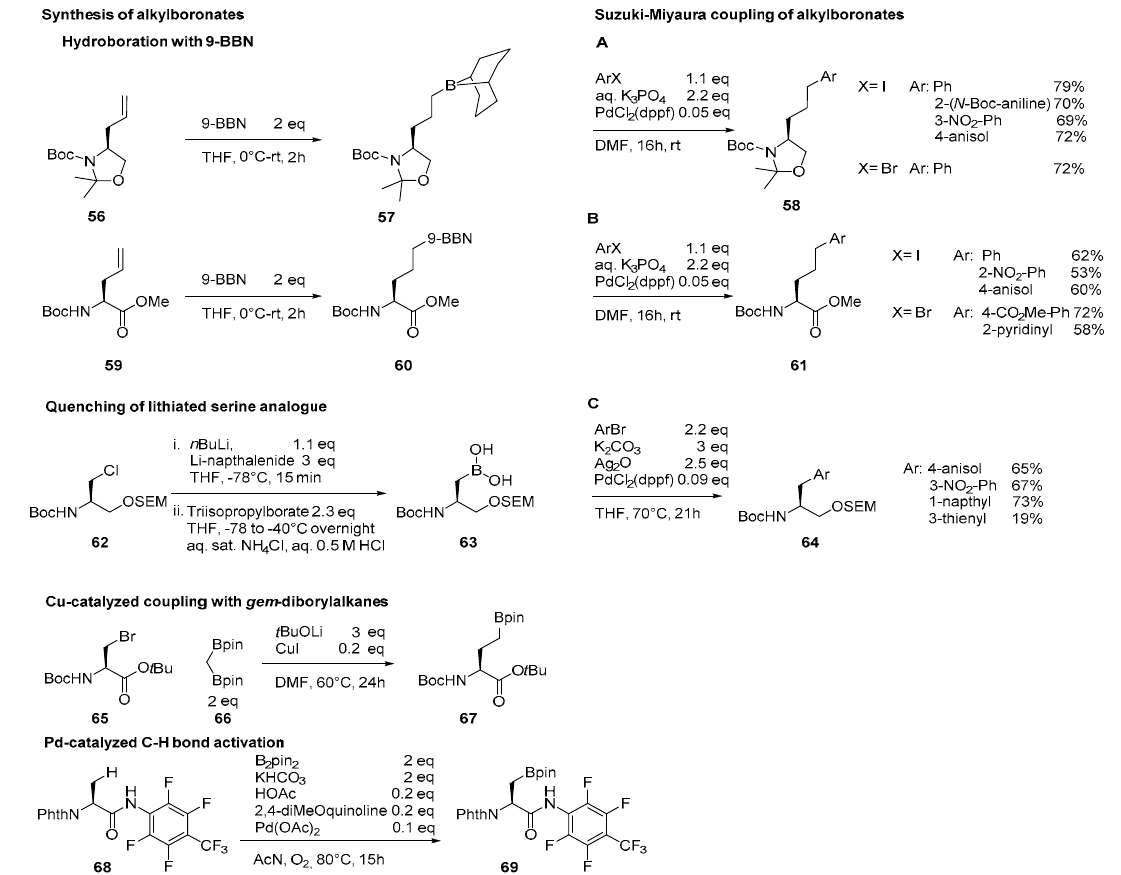
Figure 10. ( Left ) Representative examples of the preparation of amino acid alkylboronates. ( Right ) Synthesis of phenylalanine and analogues thereof prepared ( A ) via hydroboration/Suzuki–Miyaura protocol on protected allylated oxazolidine 56 ( B ) directly from protected allylglycine 59 or ( C ) from borylated serine analogue 63 .